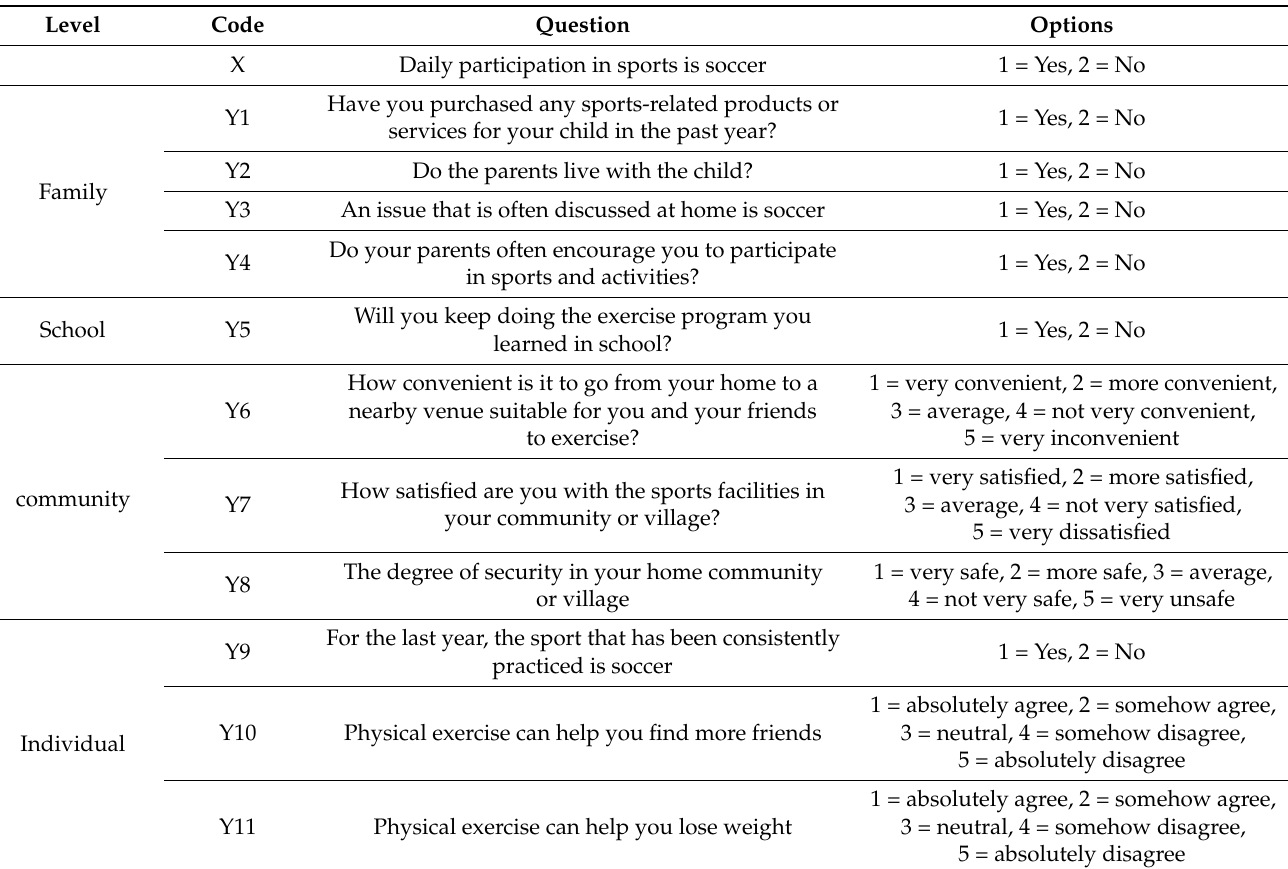
Table 3. Options corresponding to the abstraction